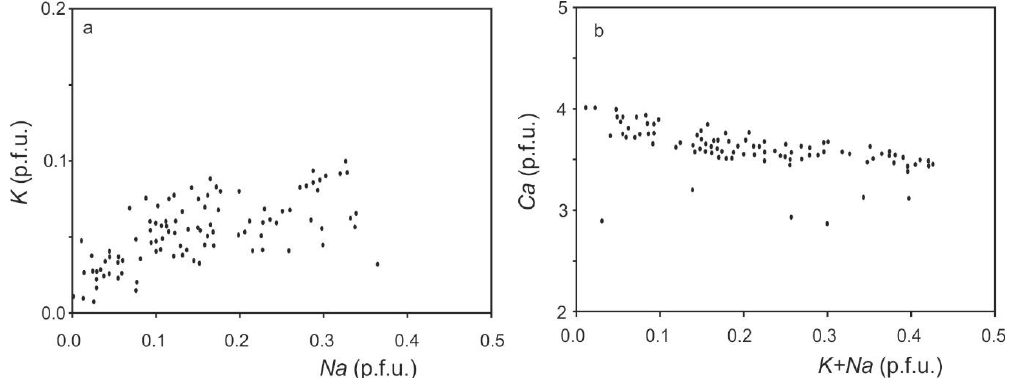
Figure 6. Chemical compositions of single laumontite crystals. ( a ) Na vs. K. ( b ) K + Na vs. Ca. Formula calculated based on 48 O.